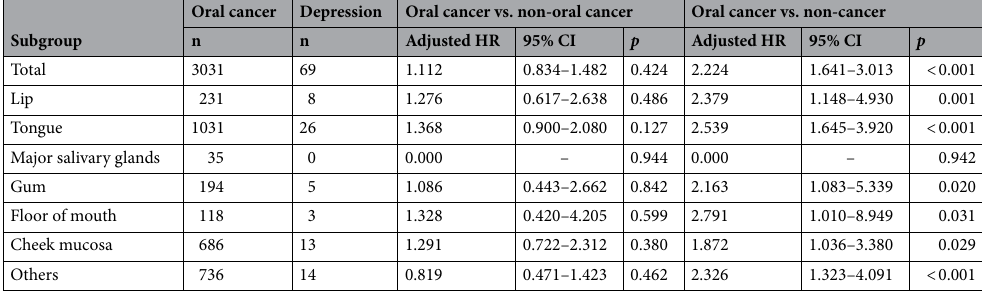
Table 3. Factors of depression stratified by oral cancer subgroup by using Cox regression. HR hazard ratio, CI confidence interval, Adjusted HR adjusted variables listed in Table